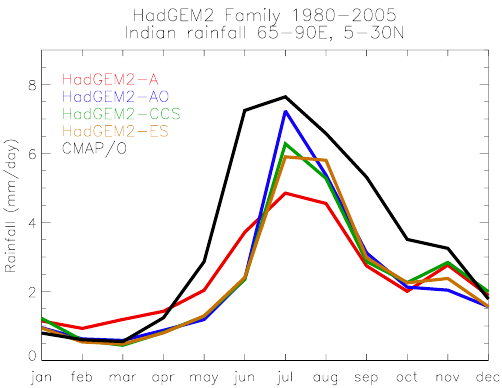
Fig. 3. Seasonal cycle of rainfall over the Indian region (65–90 ◦ E, 5–30 ◦ N) in the HadGEM2 model family, compared with